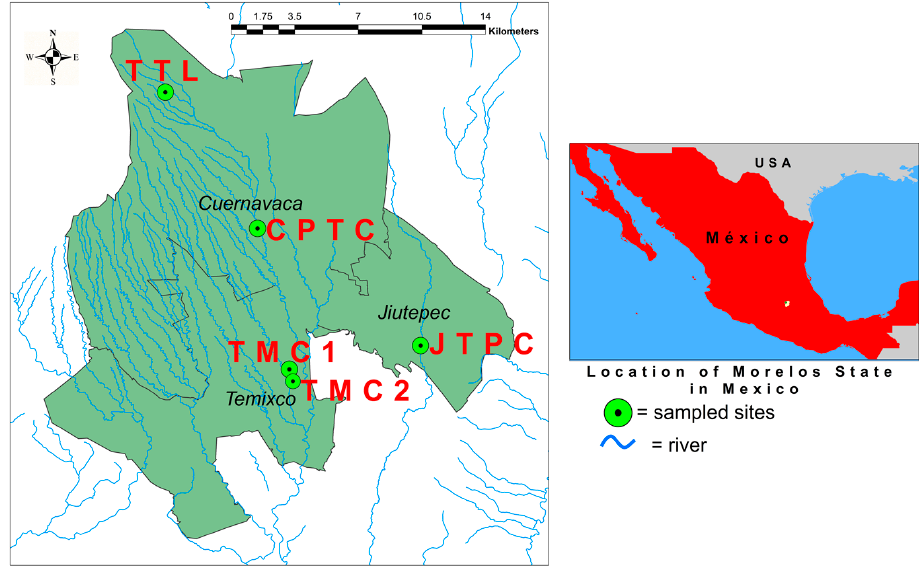
Figure 1. Sampling sites (Apatlaco river micro-basin); TTL (Tetela); CPTC (Chapultepec); TMC1 (Temixco 1); TMC2 (Temixco 2); JTPC (Jiutepec).